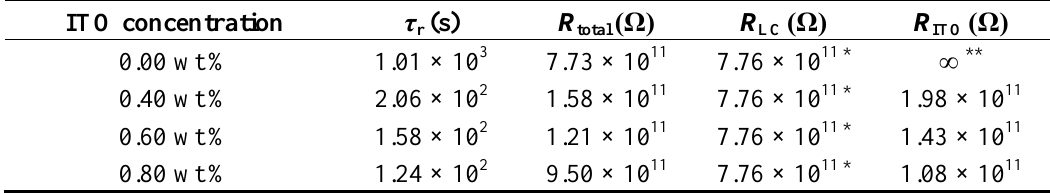
Table 2. Extracted electrical